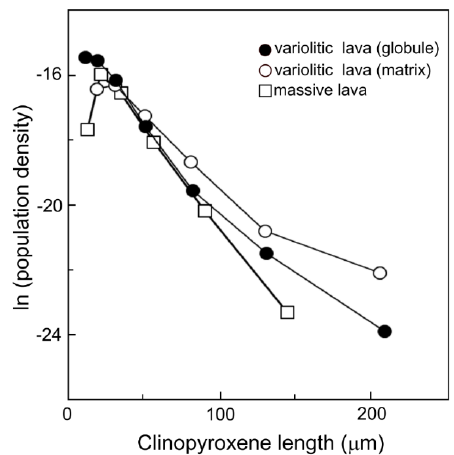
Figure 6. Crystal size distribution (CSD) of clinopyroxene crystals from of the variolitic (globule and matrix) and massive lavas from the Yalguba Ridge.